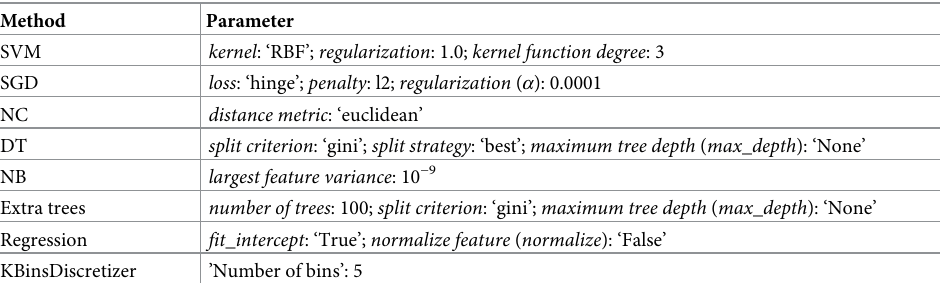
Table 2. Values of